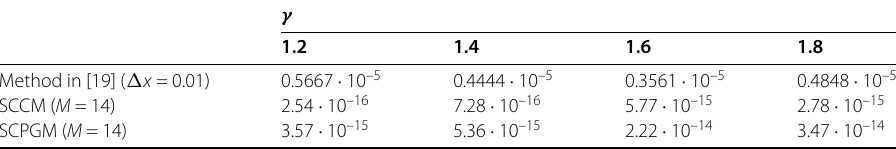
Table 3 Comparison between best errors of Example